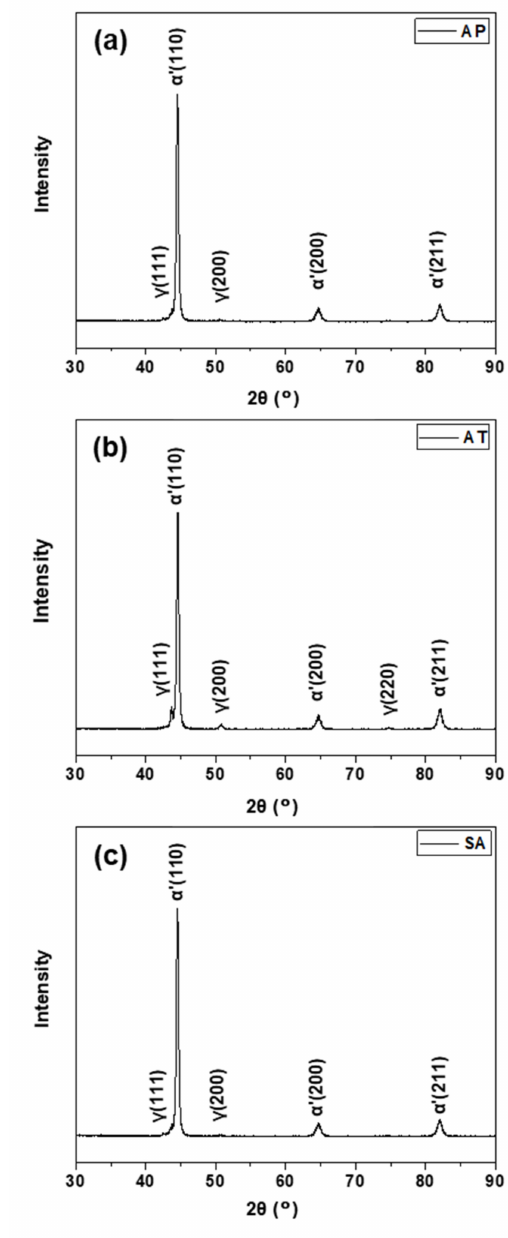
Figure 4. X-ray diffraction patterns of the ( a ) AP, ( b ) AT, and ( c ) SA samples. To better understand the crystallographic information and the distribution of phases, the inverse pole figures (IPFs) of WAAM and post-manufactured heat treatment SMSS samples obtained by EBSD are depicted in Figure 5, which are constructed along the build- ing direction considering the bcc iron representing the martensite phase, as well as the corresponding phase distribution maps in the AP, AT and SA samples. As illustrated in the IPFs of WAAM and post-manufactured heat treatment samples (Figure 5a,c,e), the majority of grains exhibit a mixture of crystallographic orientations roughly parallel to <001>, <101> and <111> directions. In addition, the IPFs of AP and AT samples present a coarse columnar microstructure. Moreover, all of samples demonstrate a hierarchical martensite microstructure composed of martensite blocks containing a group of laths with the same crystallographic orientation and whose boundaries frequently have high angle grain boundaries with misorientation angle greater than 15 degrees [34], embedded